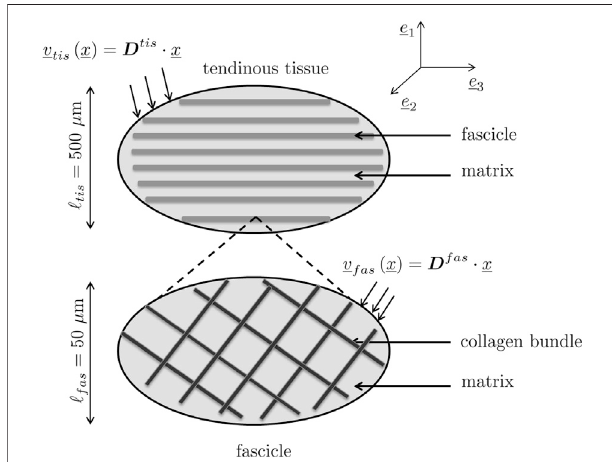
FIGURE 3 | Two-scale micromechanical representation of tendinous tissue: (top) RVE of tendinous tissue, made up by fascicle phase embedded intogel-typematrixphase; (bottom) fascicle-relatedRVEmadeupbystraight collagen bundle phases oriented in different directions and also embedded into a gel-type matrix